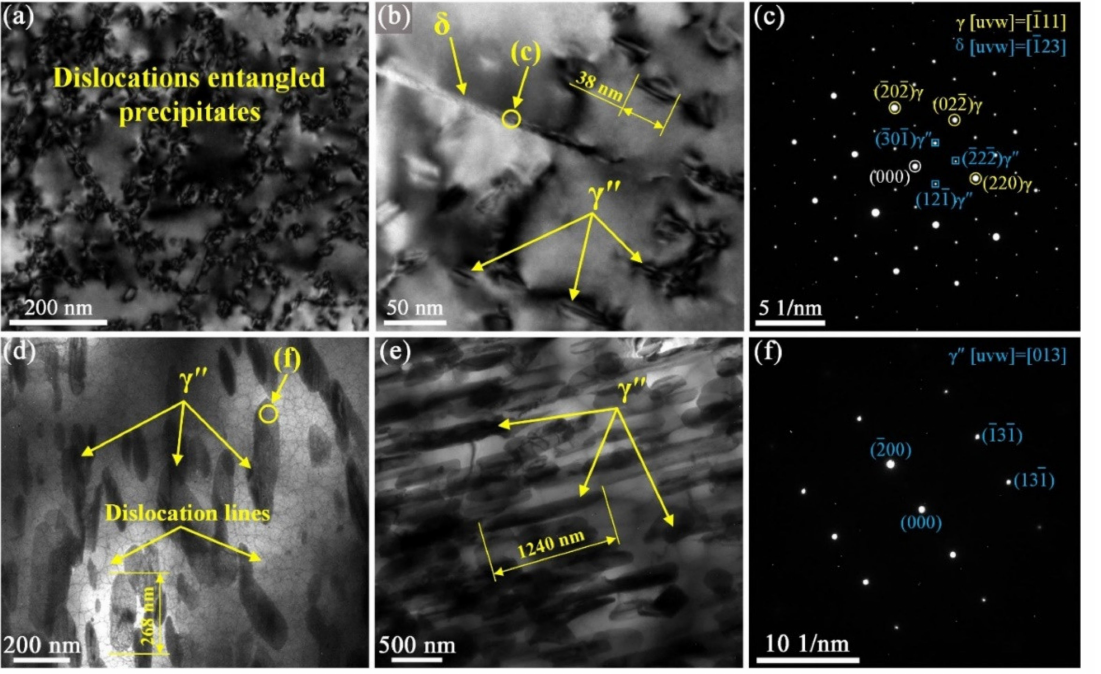
. ε = 2 × 10 − 3 s − 1 ; ( d ) LCF